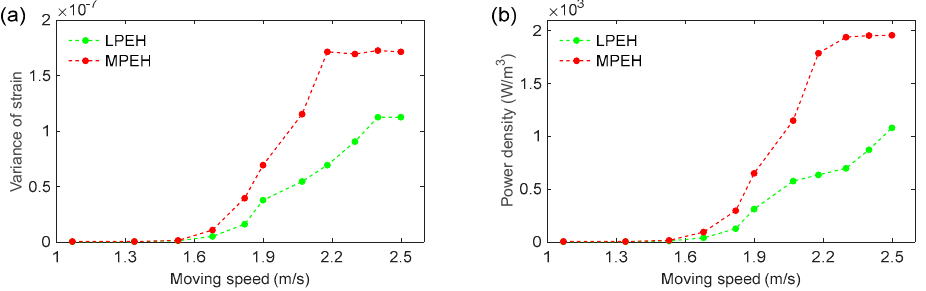
Figure 8. ( a ) Variance of strain; ( b ) power density of LPEH and MPEH for different moving speeds. To show the dynamics of the MPEH and LPEH, the time histories of strain are illus- trated in Figure 9, in which six moving speeds ( v = 1.07, 1.53, 1.82, 2.07, 2.30, and 2.50 m/s) are considered. In Figure 9, at t = 0 s, the vehicle arrives at the bridge, while the dashed line denotes the moment the vehicle leaves the bridge. The label “On bridge” represents the time interval of the vehicle moving on the bridge, while the label “Leaving bridge” represents the time interval after the vehicle leaves the bridge. In all cases, it is apparent that the strain of the MPEH is much larger than that of the LPEH when the vehicle travels on the bridge. This can be explained by the fact that an impact load acts on the bridge at the instant when the vehicle just enters the bridge. The MPEH is designed to have two magnets, with which the potential energy can be tailored to have a wide and flat bottom.